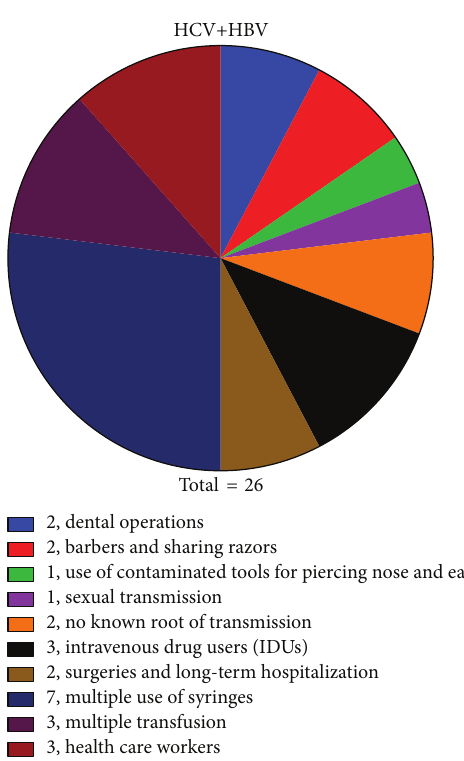
Figure 7: Risk factors associated with HCV and HBV coinfection.